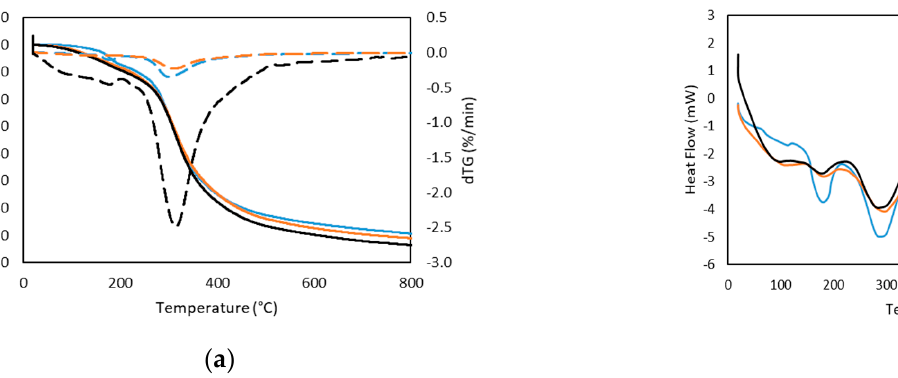
Figure 2. TGA thermogram (solid line, weight loss), and dTGA thermogram (dashed line, differential weight loss) obtained from TG curves ( a ); and DSC thermogram ( b ) of (blue line) seabass, (ochre line) trout and (black line) seabream.